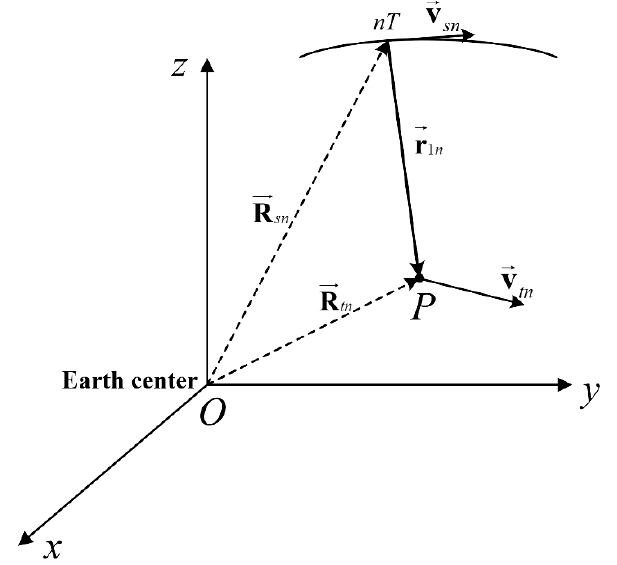
Figure 6. The propagation history of the transmitting pulse at the n th PRT. P is a point target on the earth. R sn , R tn , V sn , and V tn are the position vectors and velocity vectors of satellite and target, respectively.